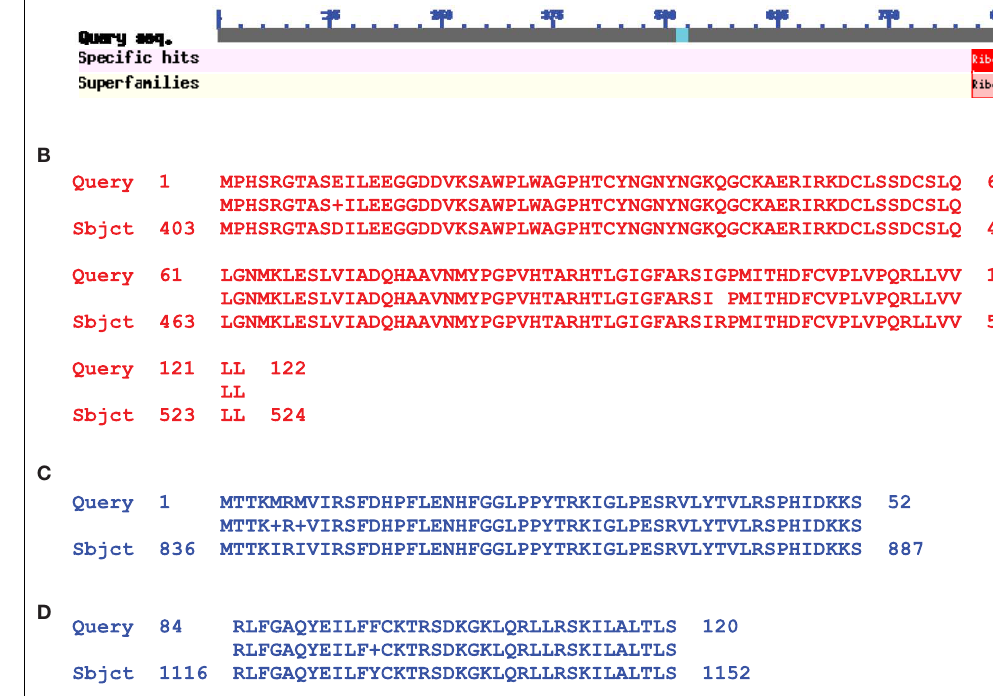
ORF135. (C,D) Blue colored parts of the sequence which is a Vicia faba CDS of rps10 gene. (C) An exon 1 sequence and (D) is an exon 2 sequence. Underlined is a sequence of nuclear alternative gene encoding putative rps10